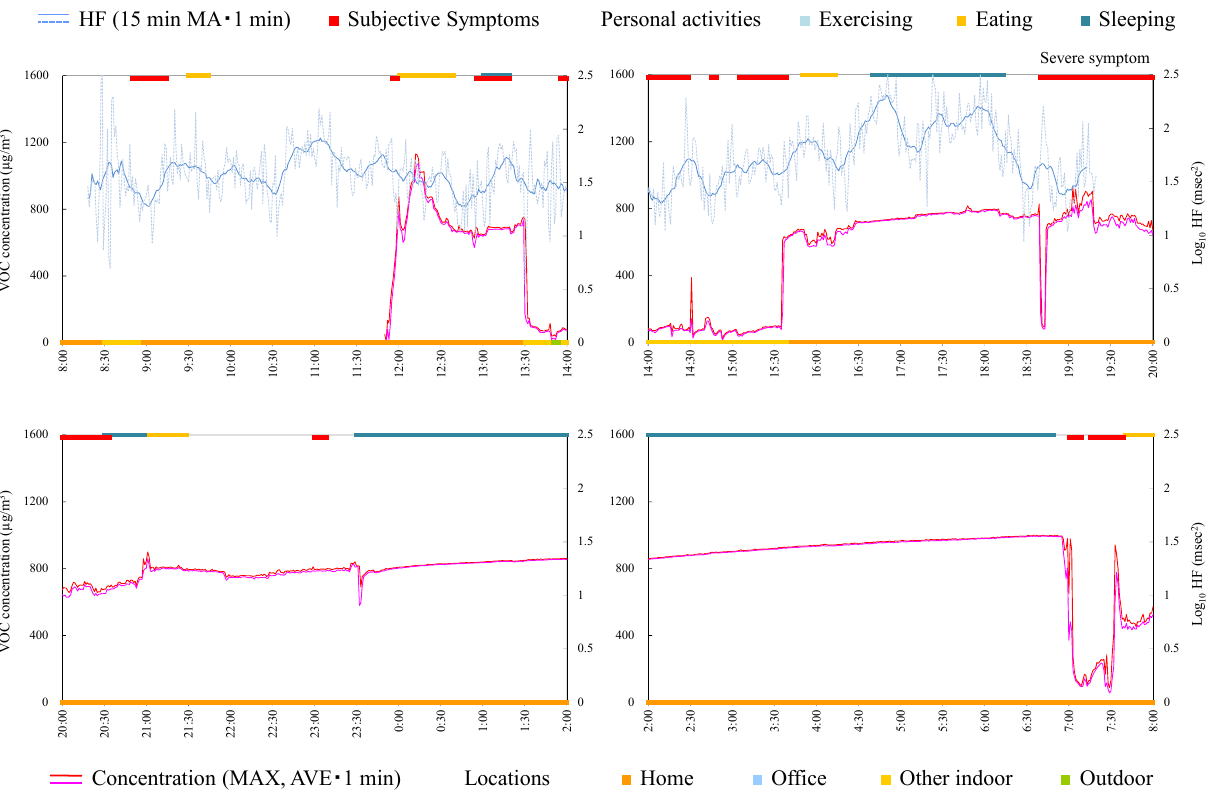
Figure 5. Time-series data of VOC concentration and log 10 HF (subject C). Subjective symptoms and personal activities are indicated in upper side and locations are indicated in lower side. The values on subjective symptoms are symptom